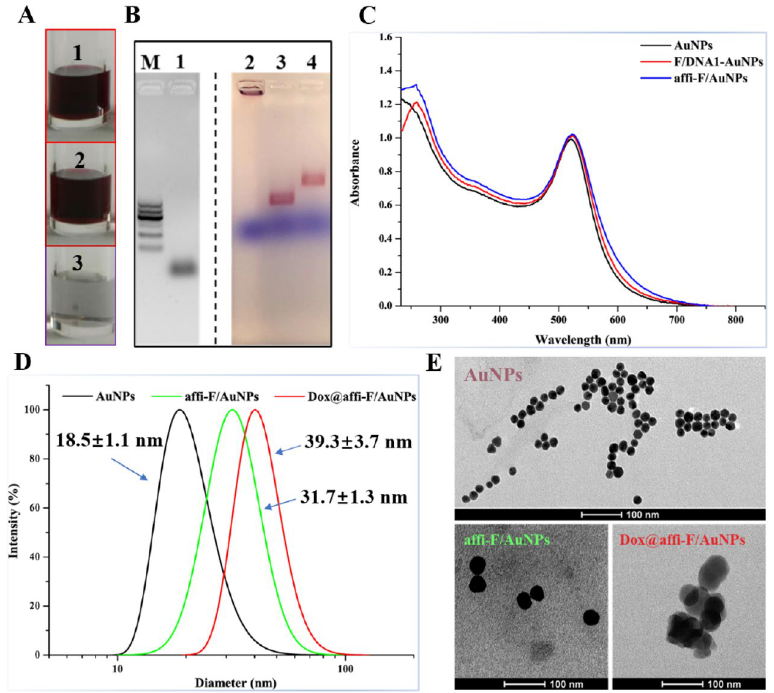
Figure 2. Characterization of affi-F/AuNPs and Dox@affi-F/AuNPs. ( A ) Digital pictures of F/DNA1-AuNPs (1), affi-F/AuNPs (2) and AuNPs (3) after suspension in PBS buffer and overnight storage. ( B ) Agarose gel analysis of affi-F/AuNPs (UV-imaging of gel is on the left of the dividing line, and brightfield imaging of gel is on the right). Lane 1, F/DNA1-SH; Lane 2, AuNPs; Lane 3, F/DNA1-AuNPs; Lane 4, affi-F/AuNPs. ( C )